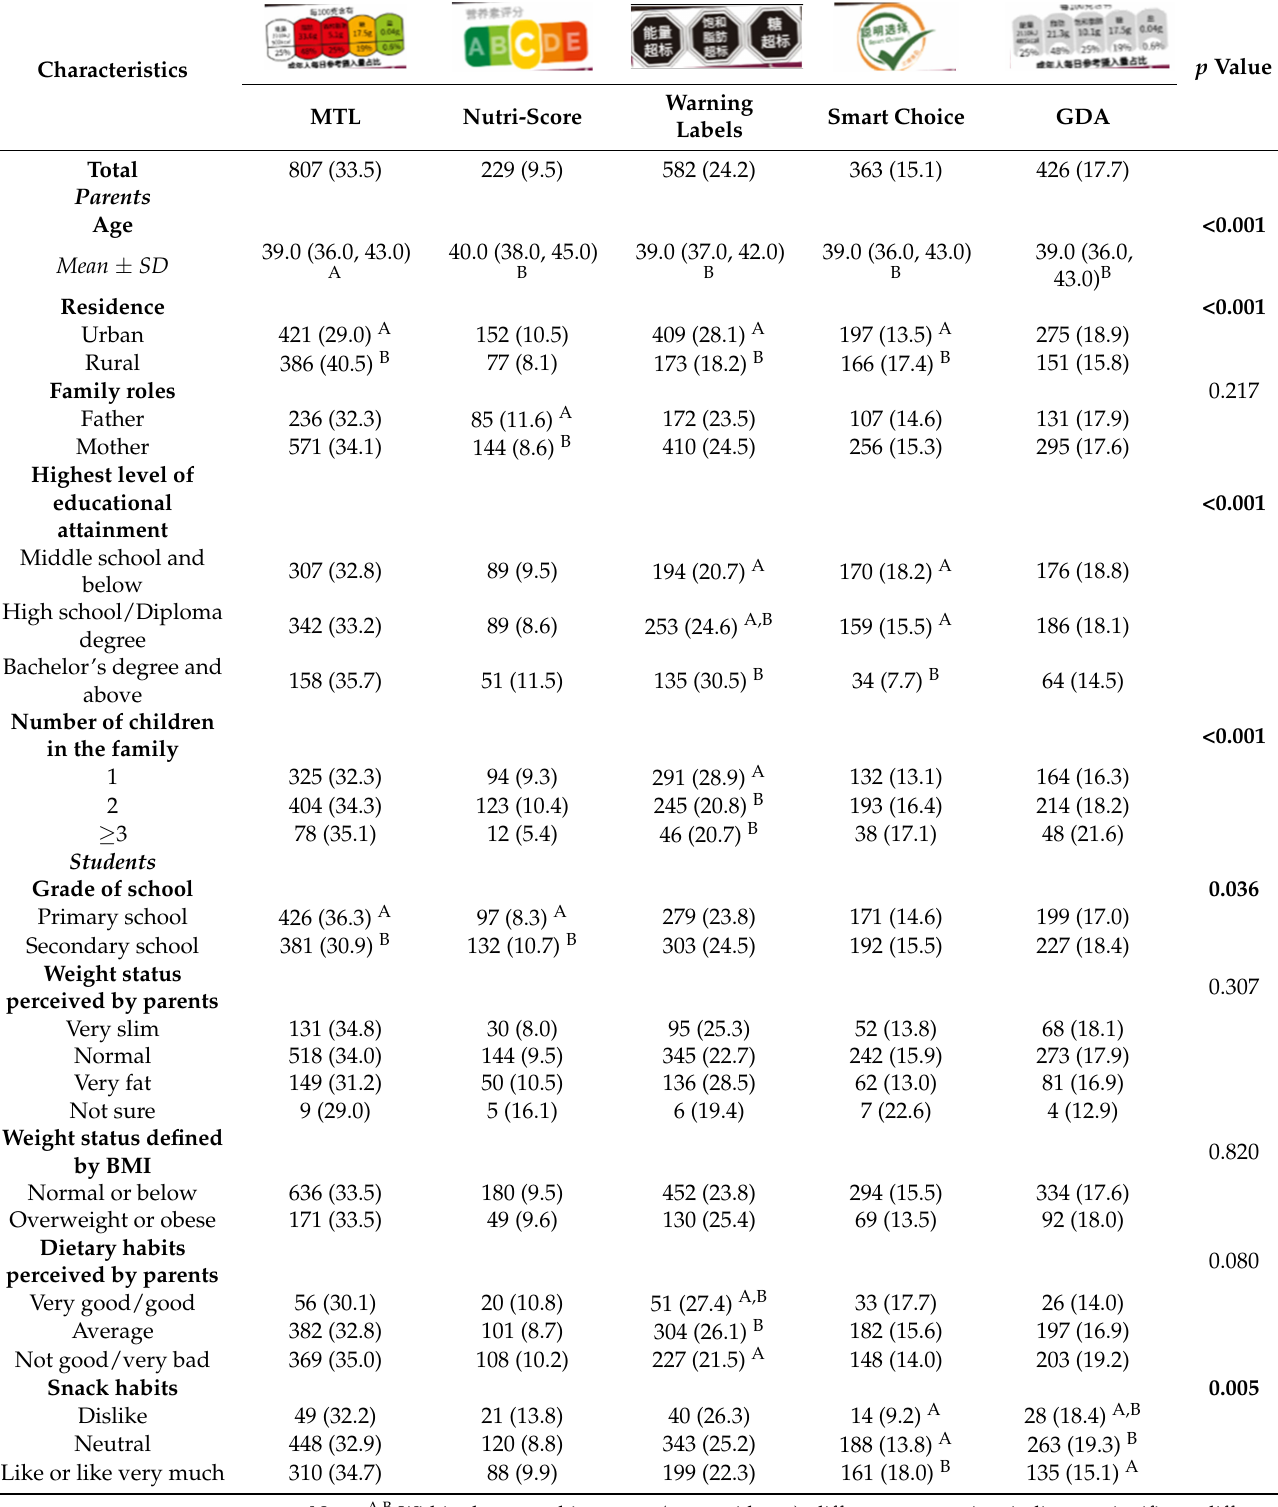
Table 4. FOPL format helping Chinese parents select healthier food quickly most: n